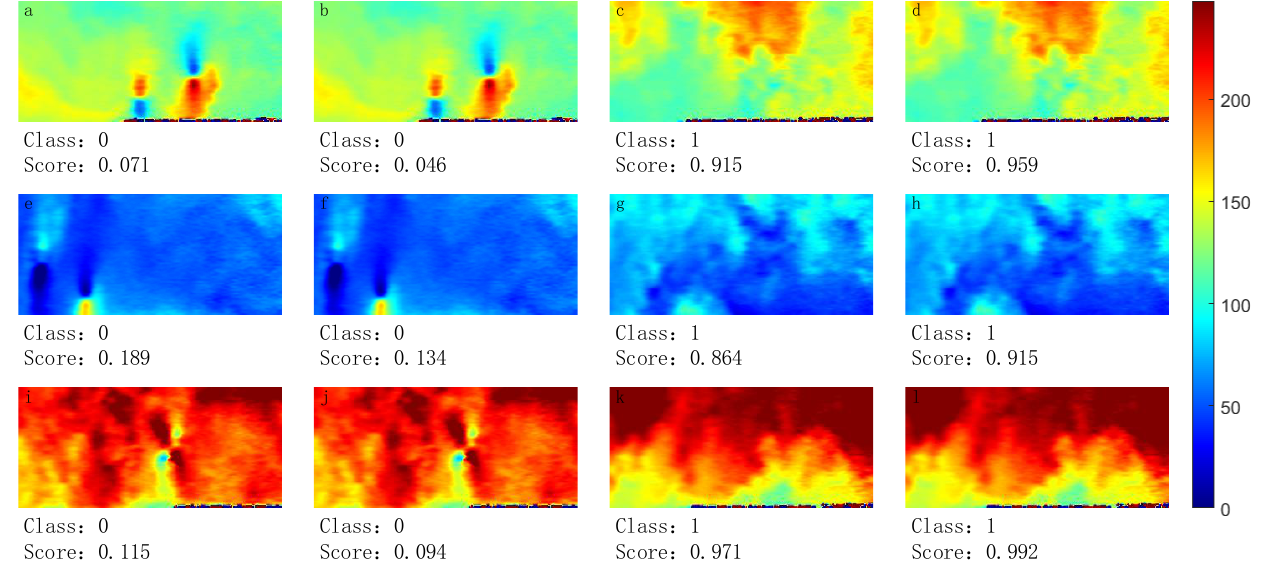
Figure 13. Visualization of wake recognition. ( a , b , e , f , i , j ) with wake; ( c , d , g , h , k , l ) without wake; ( a , c , e , g , i , k ) by ParNet; ( b , d , f , h , j , l ) by improved ParNet.